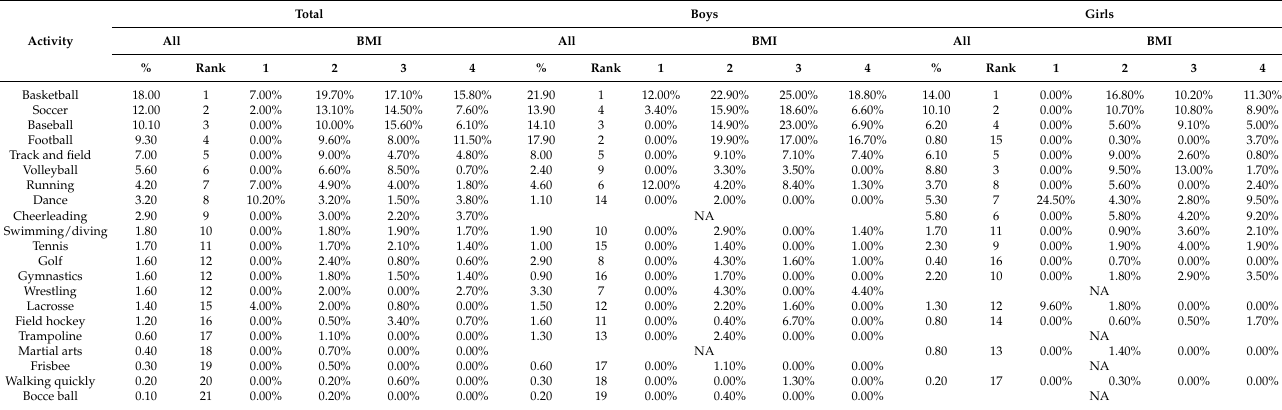
Table 5. Ranking of physical activities (PA) inside school in 2012 (BMI: 1 = Underweight, 2 = Normal weight, 3 = Overweight, 4 = Obese); NA = No participation by boys or girls in this specific activity. Activity